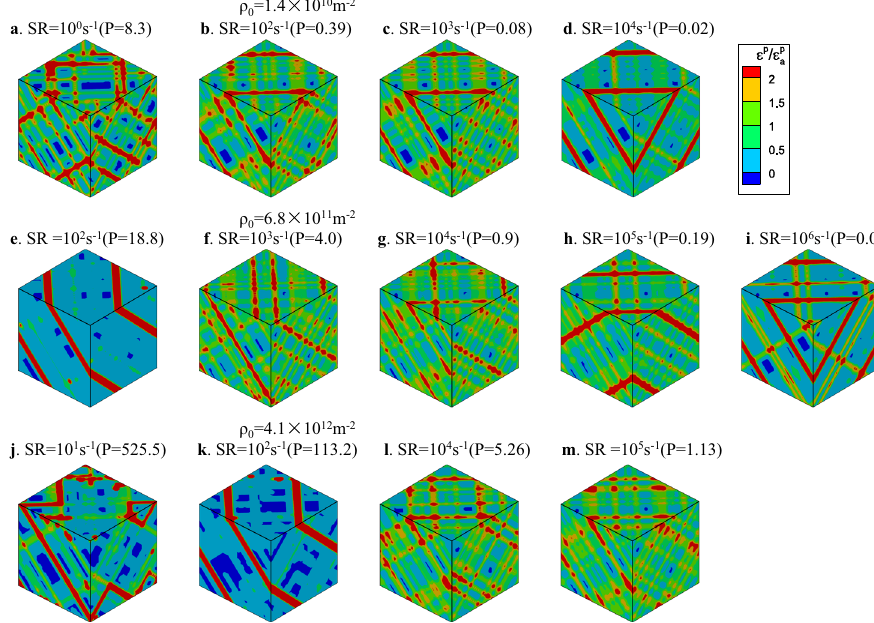
Fig. 4 Contours of plastic strain for different initial dislocation densities and strain rates. In a . SR = 10 0 s − 1 , b SR = 10 2 s − 1 , c SR = 10 3 s − 1 and d SR = 10 4 s − 1 , ρ 0 = 1.4 × 10 10 m − 2 . In e SR = 10 2 s − 1 , f SR = 10 3 s − 1 , g SR = 10 4 s − 1 , h SR = 10 5 s − 1 and i SR = 10 6 s − 1 , ρ 0 = 6.8 × 10 11 m − 2 . In j SR = 10 1 s − 1 , k SR = 10 2 s − 1 , l SR = 10 4 s − 1 and m SR = 10 5 s − 1 , ρ 0 = 4.1 × 10 12 m − 2 . Plastic strain is given in units of mean plastic strain. In each row, the initial dislocation con fi guration is the same. The edge lengths of the depicted simulation boxes are 55.34 μ m in the fi rst row ( a – d ), 7.91 μ m in the second row ( e – i ), 3.23 μ m in the third row ( j – m ). SR is abbreviation of strain